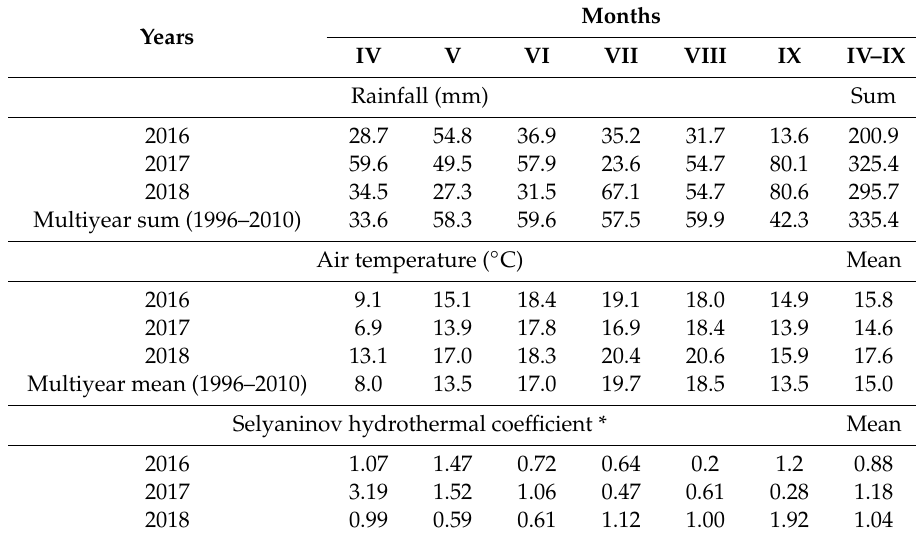
Table 4. Weather conditions during of potato vegetation (Zawady Meteorological Station, (52 ◦ 03 (cid:48) N and 22 ◦ 33 (cid:48) E),